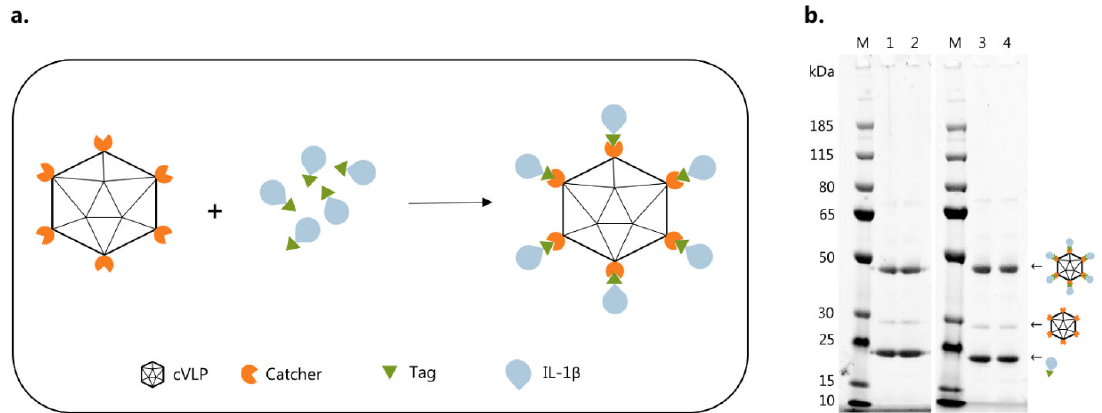
Figure 2. Vaccine formulation. ( a ) Schematic representation of the Tag/Catcher ‐ AP205 technology used to create the cVLP:IL ‐ 1 β vaccines. Genetic fusion of the split ‐ protein Catcher to the AP205 capsid protein (total of 180 subunits per cVLP) allows for high ‐ density, unidirectional display of IL ‐ 1 β antigens fused to the corresponding binding Tag. ( b ) M: marker, lane 1: cVLP:IL ‐ 1 β after O/N incubation at 4 °C (48 kDa), lane 2: cVLP:IL ‐ 1 β after O/N incubation at 4 °C (48 kDa) + spin test, lane 3: cVLP:IL ‐ 1 β Q15G after O/N incubation at 4 °C (48 kDa), lane 4: cVLP:IL ‐ 1 β Q15G after O/N incu ‐ bation at 4 °C (48 kDa) + spin test. Excess IL ‐ 1 β‐ Tag antigen (21 kDa) and unconjugated cVLP sub ‐ units (27 kDa) were present in all the coupling reactions.